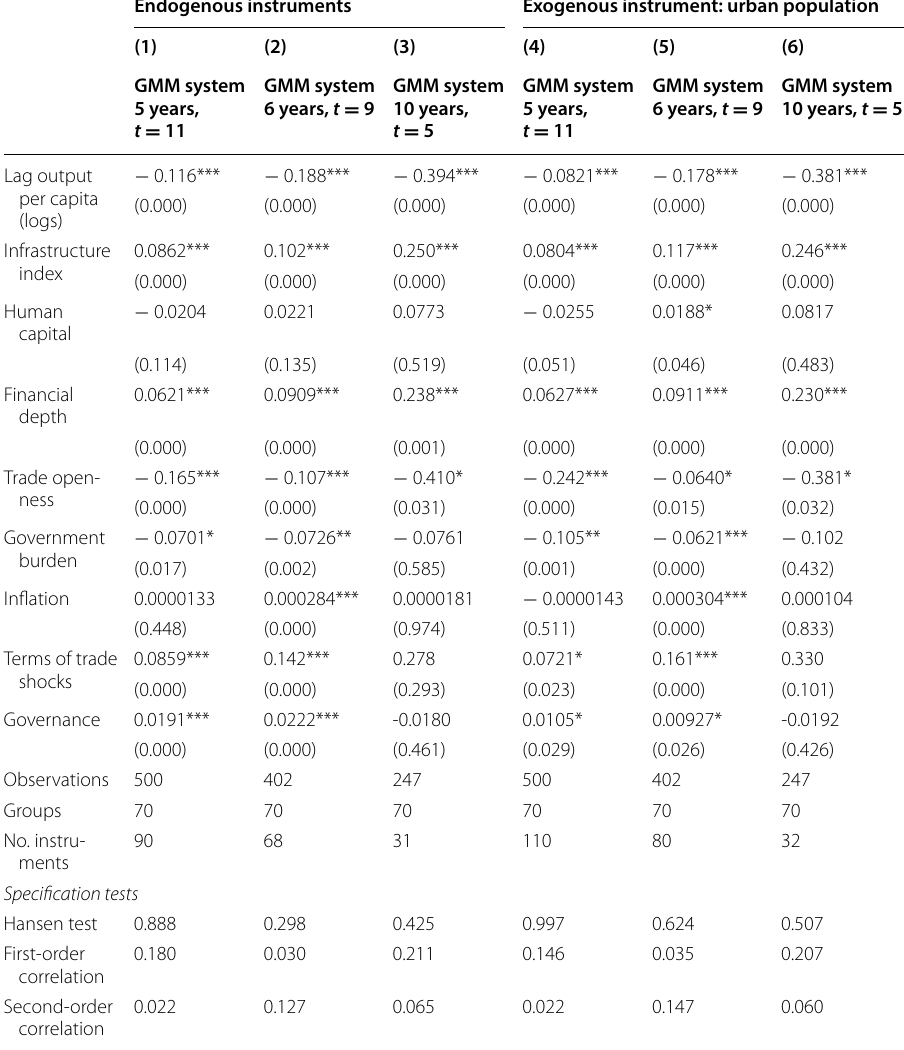
Table 4 Infrastructure stocks and economic growth: panel regression